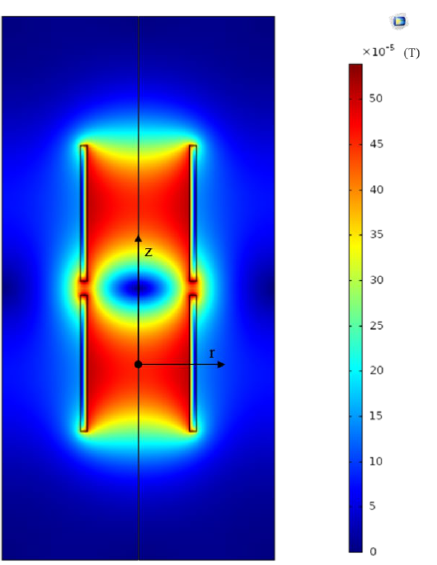
Figure 10. The magnetic flux density distribution of an excitation coil.